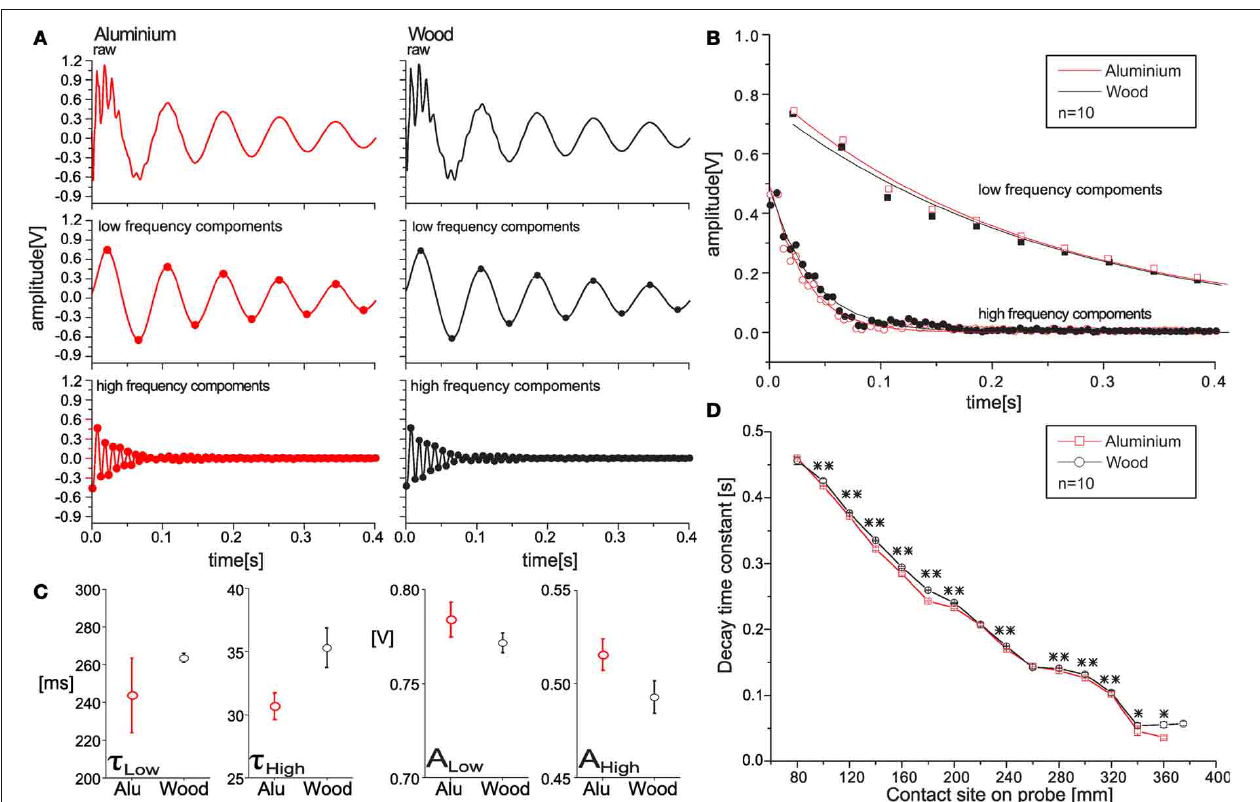
time constants, τ , and amplitudes, A, for both frequency components ( n = 10, means ± s.d.). Hence, analysis of decay time constants allows material classification. Note that data in (C) correspond to a single contact distance. (D) Dependence of decay time constants on contact site. Two materials were compared, a soft wood rod (circles) and an aluminium rod (squares). Time constants were calculated from slopes of linear fits to log-transformed peaks of low-frequency components. Error bars depict the SD, asterisks label statistically significant differences ( n = 10; ∗∗ p < 0 . 001; ∗ p < 0 .